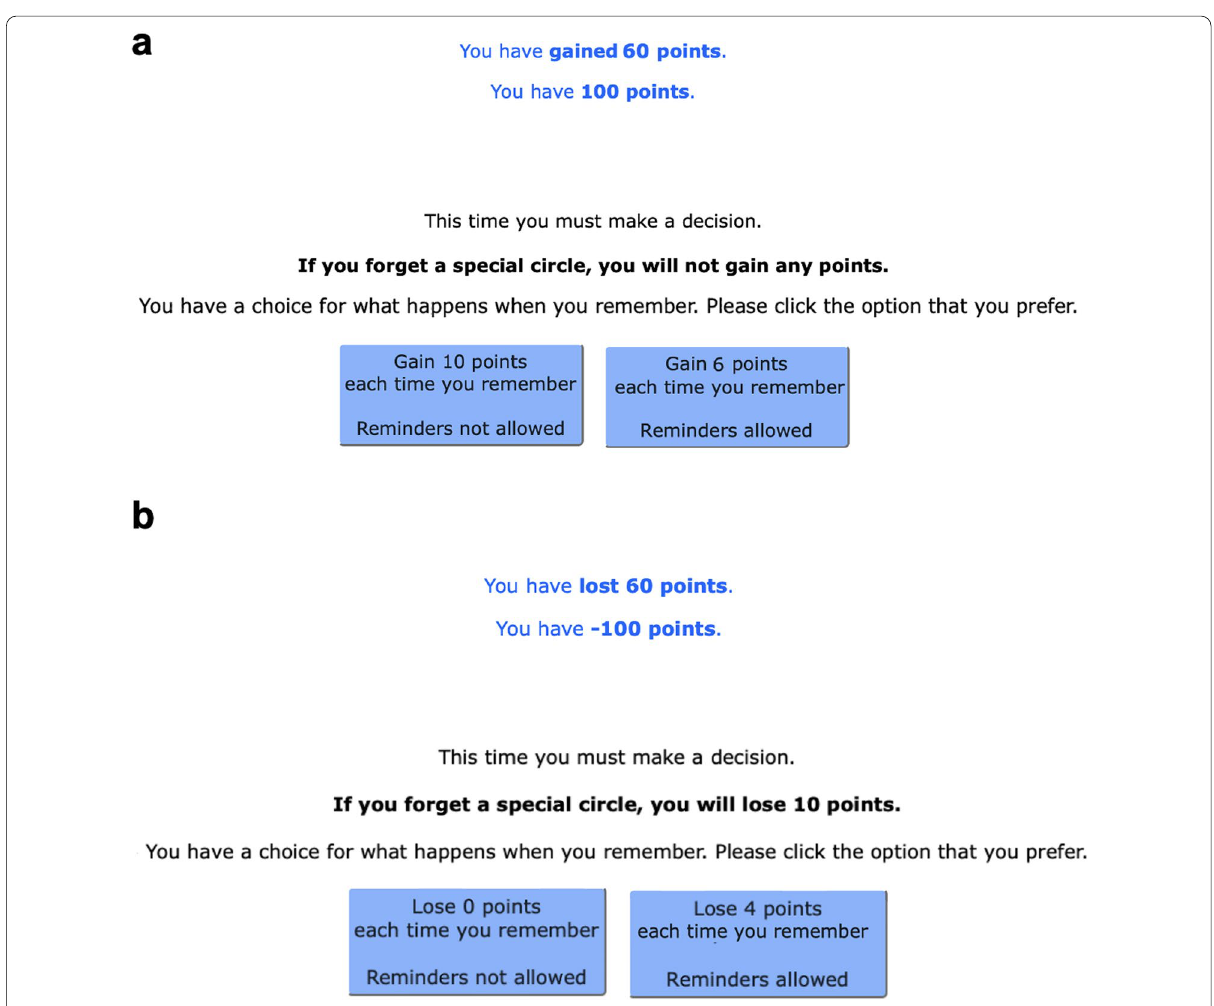
Fig. 2 Example instructions for the free‑choice trials. Note Prior to the start of each free‑choice trial, participants were given the choice to either rely on their internal memory or to set external reminders. a In the gain condition, participants would score 10 points for each special circle they remembered if they relied on their memory or a smaller number of points (1–9) if they selected to set reminders. b In the loss condition, if participants relied on their memory, they would lose 0 points for each special circle they remembered. If they chose to use reminders, however, they would score minus points ( 9 to 1). For both framing conditions, a sequence of 25 circles was presented in each trial, with 10 of them acting − − as special